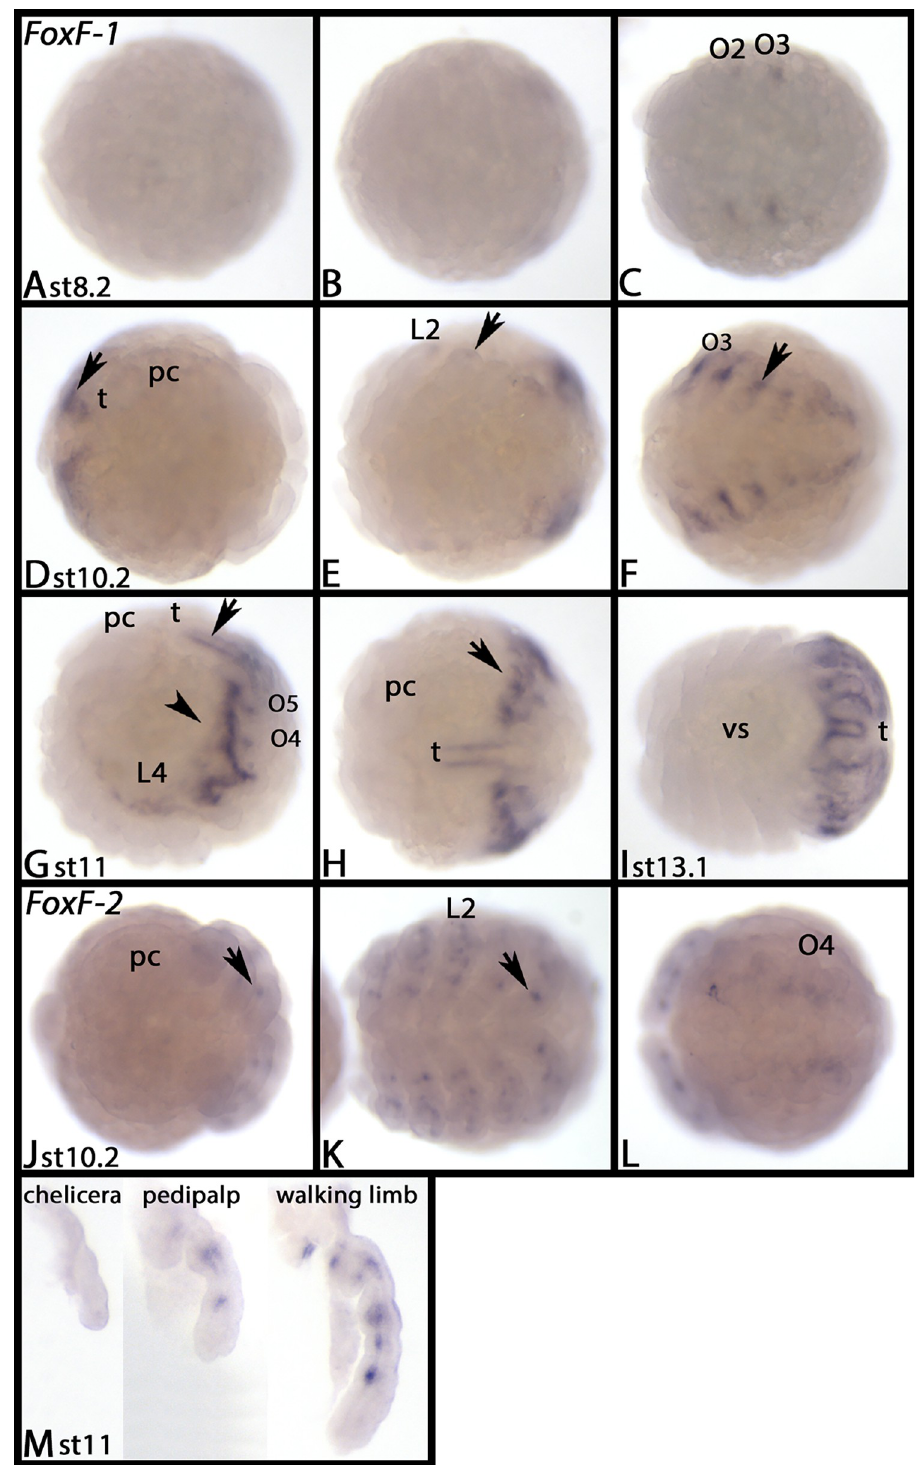
Fig 9. Expression of Parasteatoda FoxF-1 (A-I) and FoxF-2 (J-M). In all panels, anterior is to the left, ventral views, except panels G and M, lateral views, and H, dorsal view. Each row represents the same embryo, if not of different developmental stage. Arrows in panels D-H point to expression in the opisthosoma, and in panels J and K the legs. Abbreviations in Table 2. DAPI staining of the embryos shown in this figure are presented in S12 Fig.